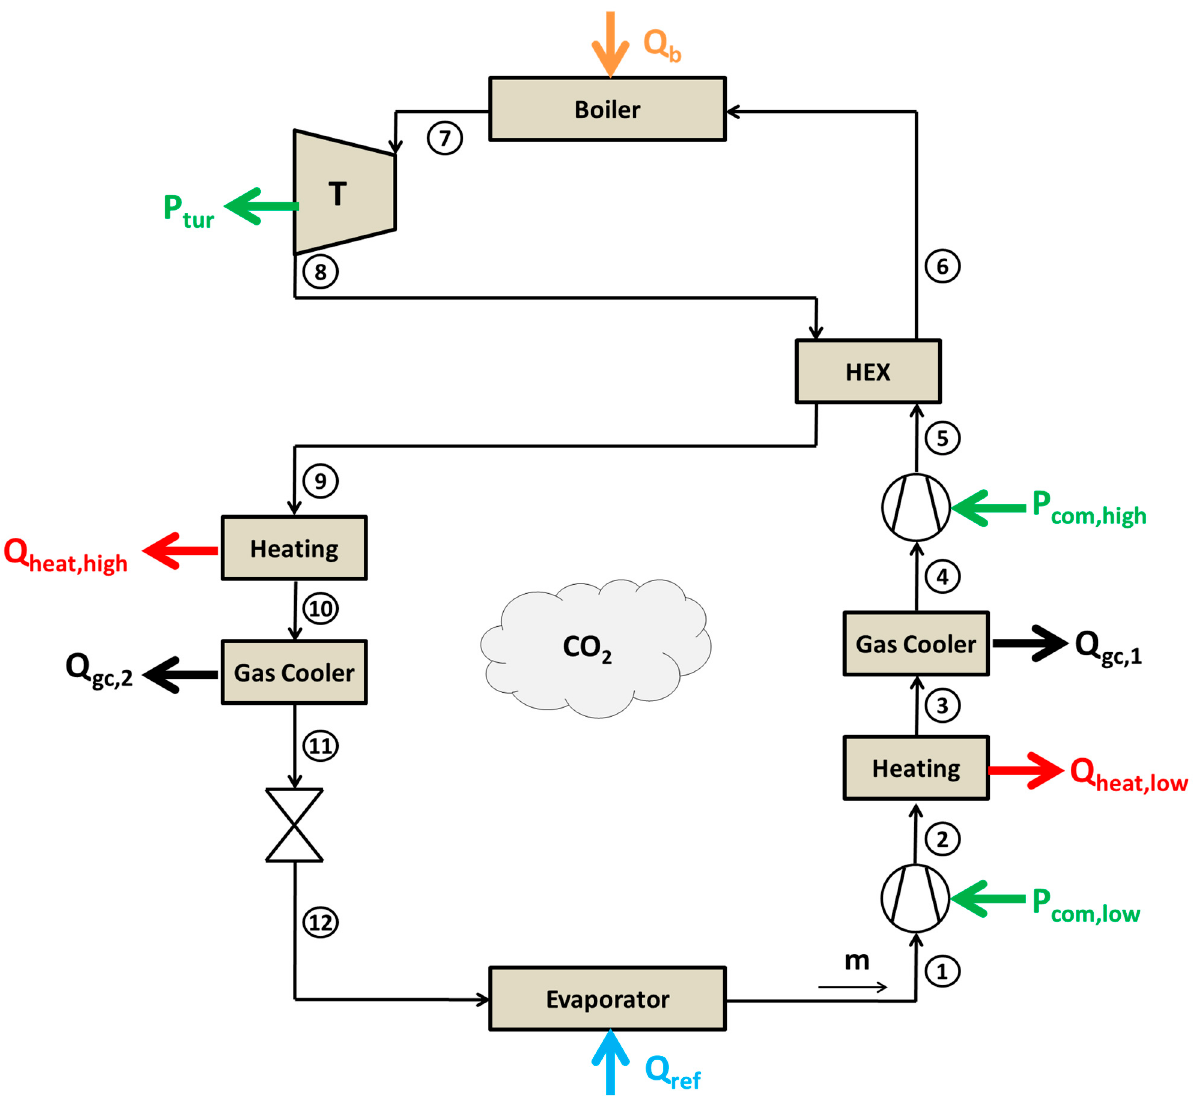
Figure 1. The examined polygeneration system with CO 2 working fluid.